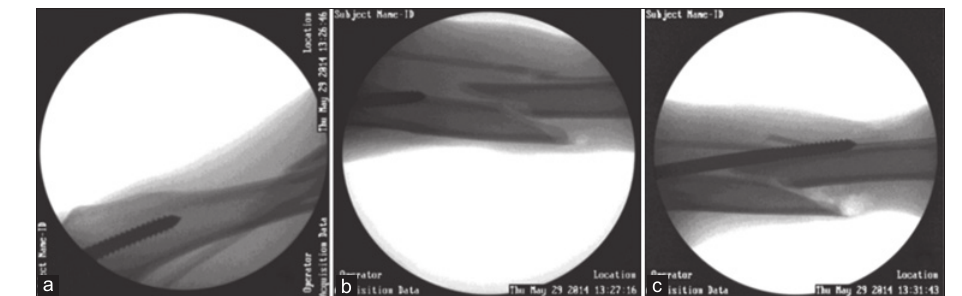
Figure-7: Complications of C-arm guided pinning: Misdirection of the pin and formation of false tract. (a) Pin inserted into the proximal fragment of the bone, (b) Misdirection of the pin out of the cortex of the proximal fragment, (c) Pin entering the same false tract on attempting the pinning multiple Table-4: Bone wise success rate of C-arm guided intramedullary pinning. Outcome